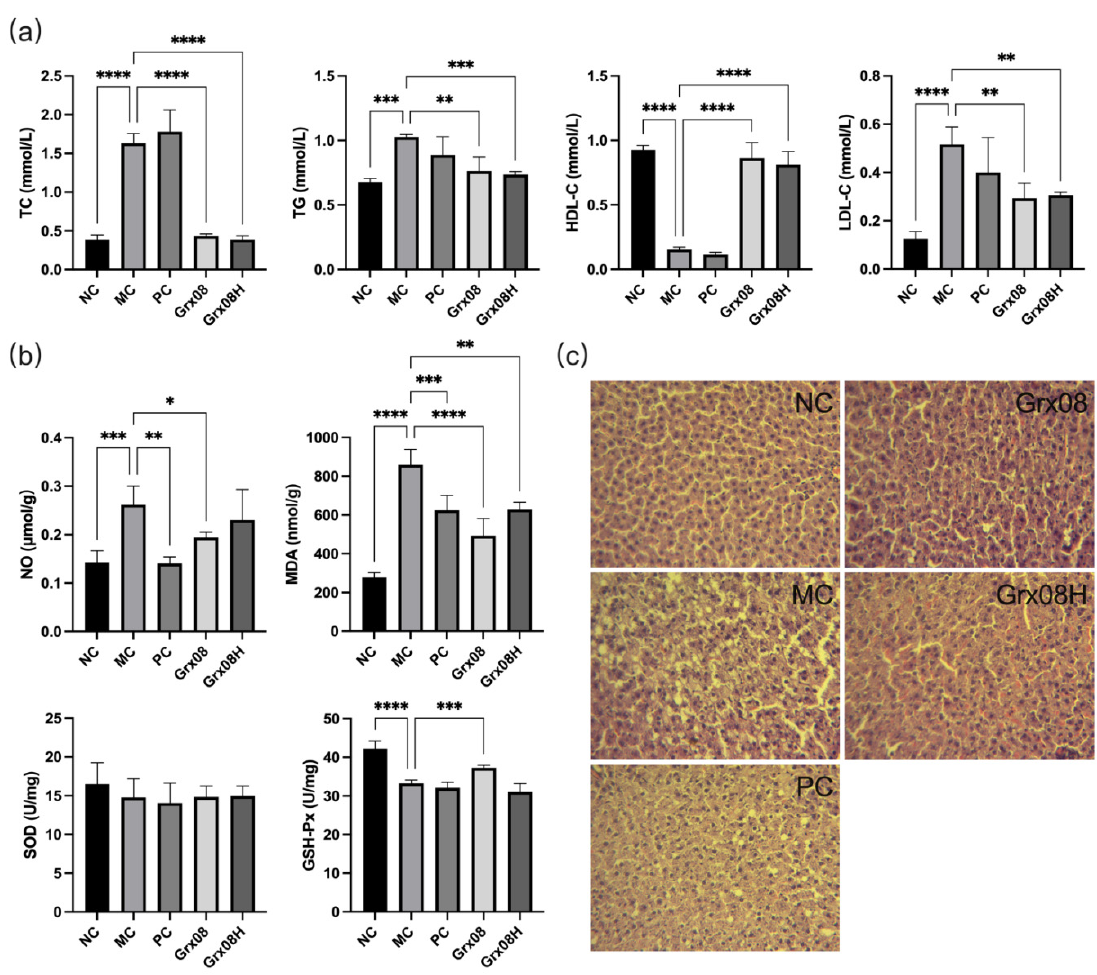
Figure 2. Effect of probiotics on anti-oxidative stress of rat liver ( n = 5). ( a ) Lipid accumulation in rat liver, ( b ) Oxidative damage and antioxidant enzymes activity in rat liver, ( c ) Case study of rat liver ( × 200). * indicates a significant difference between groups ( p < 0.05), ** indicates a significant difference between groups (p < 0.01), *** indicates a significant difference between groups ( p < 0.001), **** indicates a significant difference between groups ( p <